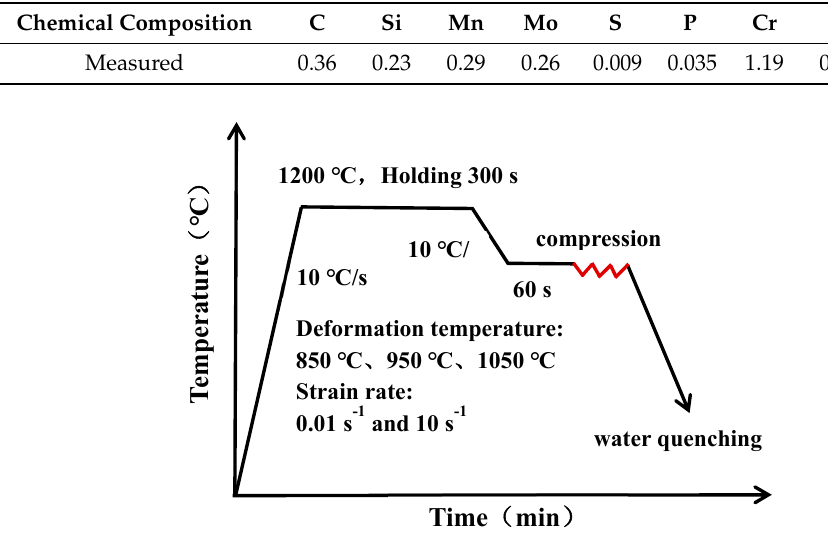
Table 1. Composition of GB 35CrMoV steel (wt%).